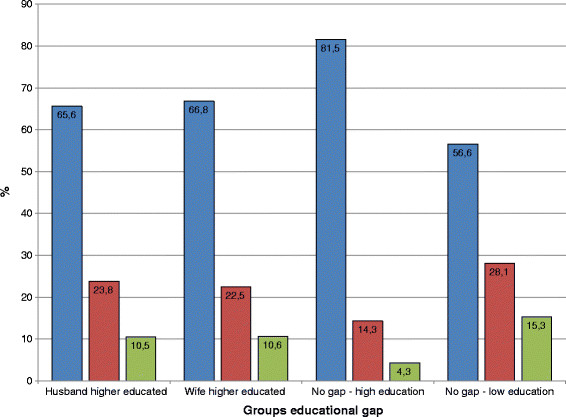
Women's violence experienced stratified for spousal education gap value in Bangladesh 2007 (n = 4,187) and India 2005/06 (65,111) (in %), Blue – No violence experienced. Red – Only less severe violence experienced. Green – Severe violence experienced.